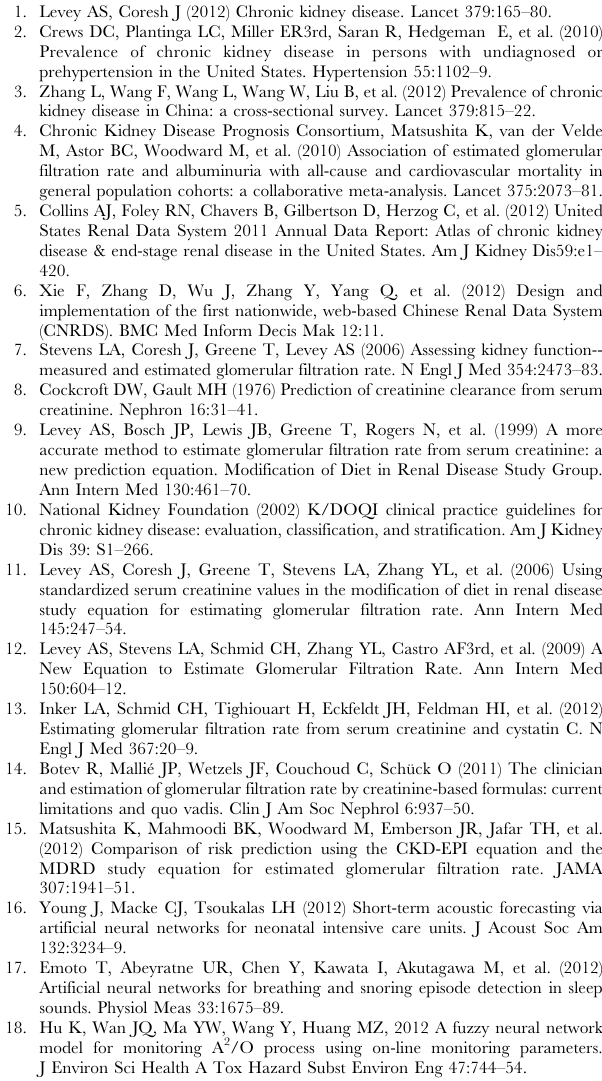
Table S19 Classification the CKD stage by the estima- tion models in different stages of CKD. (DOC) File S1 An Excel table based on the six-variable GABP network to estimate GFR.